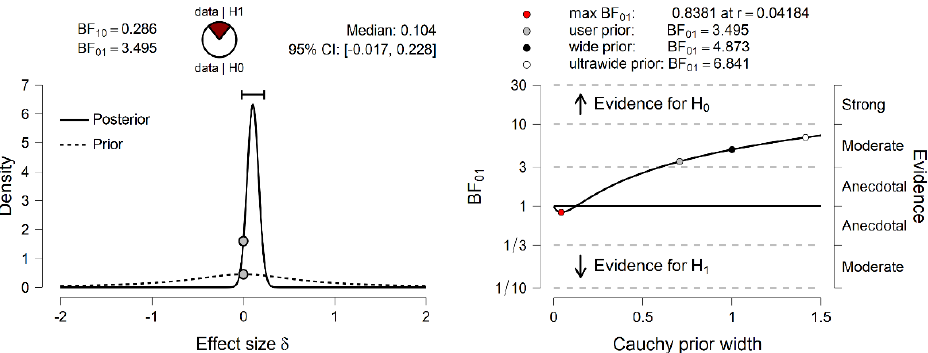
Figure 1. Efficacy. Bayesian Independent Samples t -Test [Inferential plots: ( Left panel ) Prior and Posterior; ( Right panel ) Bayes Factor Robustness Check].